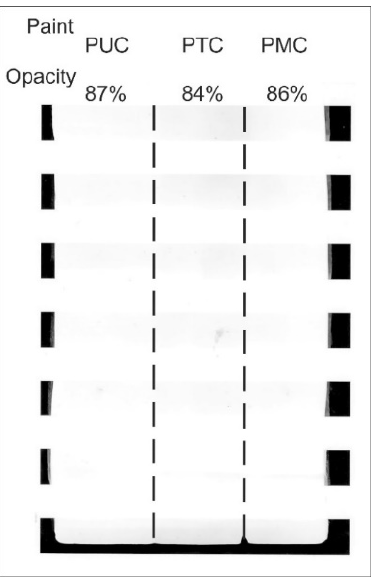
Figure 1. PUC, PTC, and PMC films on the Leneta chart. While the agglomeration of the pigment grains and their poor dispersion in the matrix decreases the hiding power, well-dispersed grains and optimized grain size increase the hiding power of the paint. In this study, no visible signs of agglomeration were